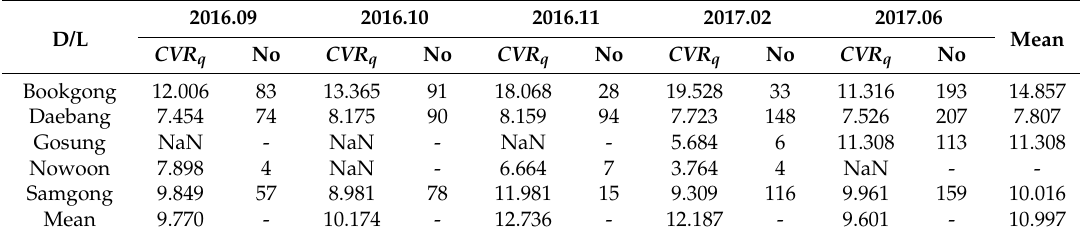
Table 8. CVR factor of the reactive power of the Chimsan substation (MAD direct method).